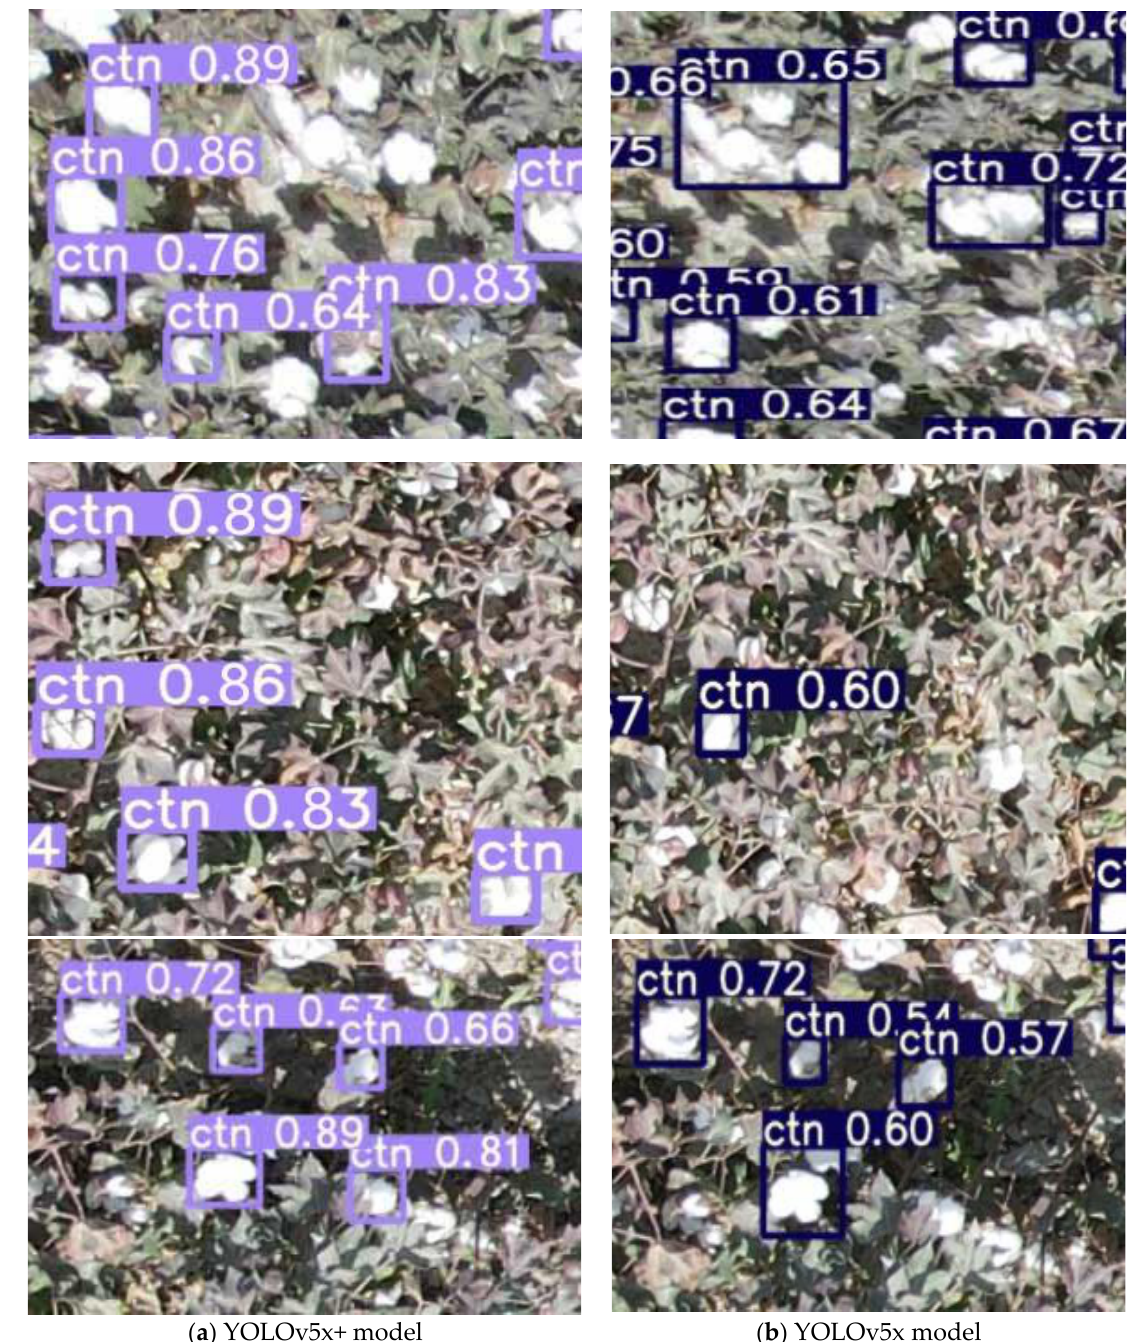
Figure 12. Comparison of test results.